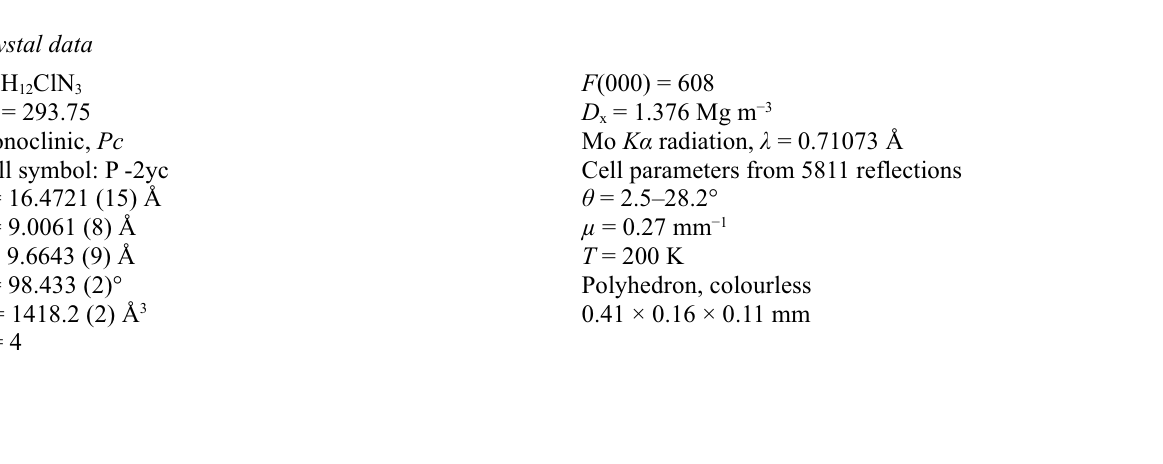
Enhanced figure of both independent molecules of the title compound with displacement ellipsoids plotted at 50% probability